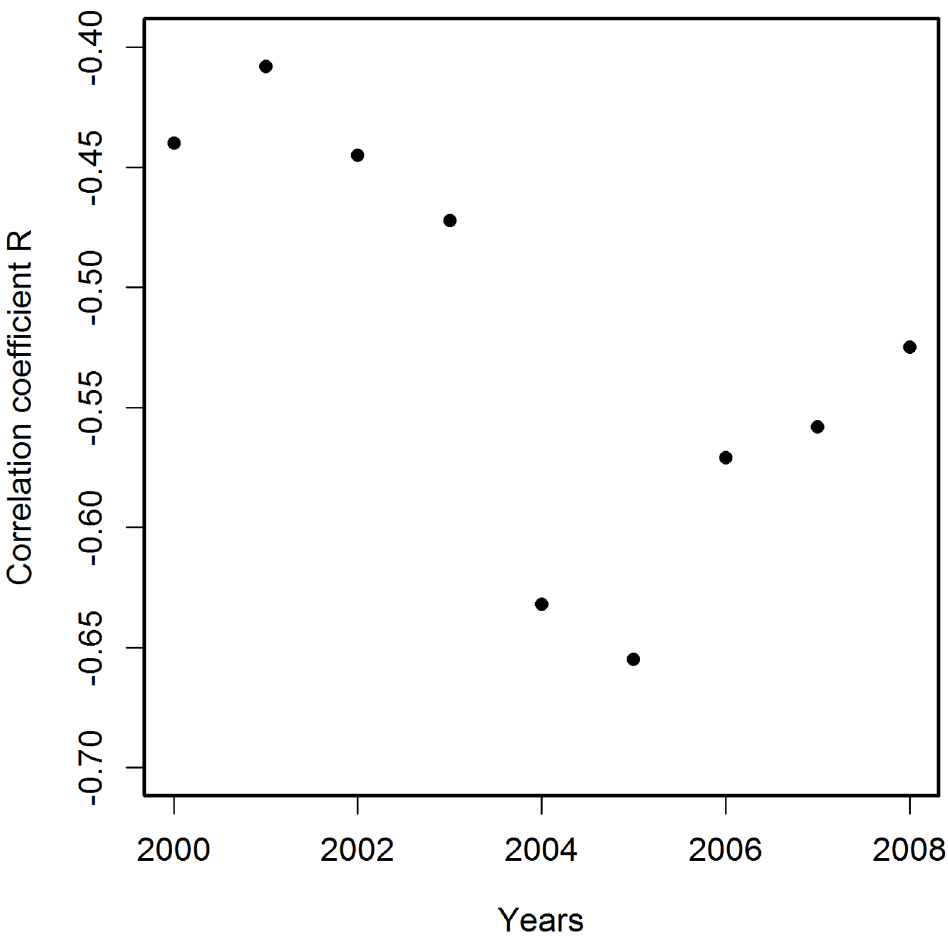
Fig 2. Correlation coefficients R for correlations of PCPI in 1970 (in 51 states of the USA) with age- adjusted AD death rates (AADRs) in the respective states in the period 2000 – 2008. The best correlation is observed for deaths data for 2005. Death rates are represented by the number of cases per 100 000 population adjusted for age